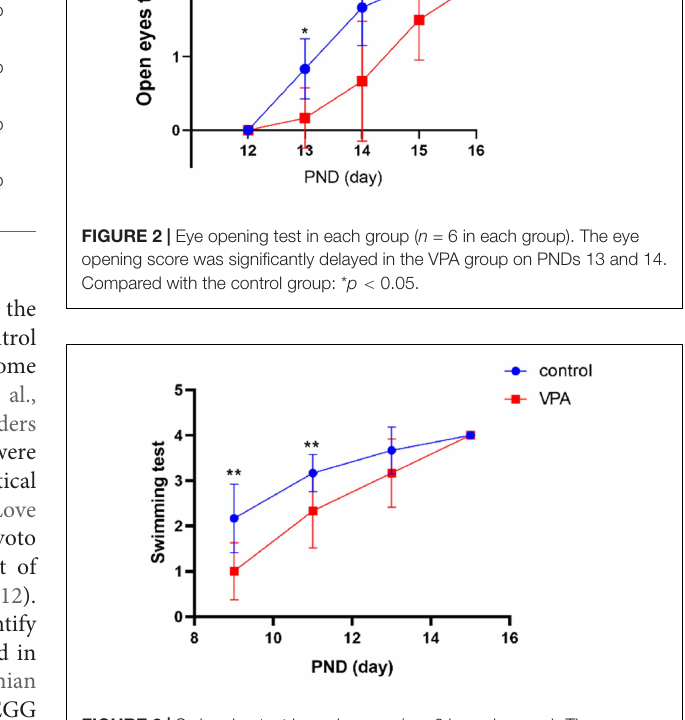
FIGURE 3 | Swimming test in each group ( n = 6 in each group). The swimming score was significantly delayed in the VPA group on PND9 and PND11. Compared with the control group: ** p <